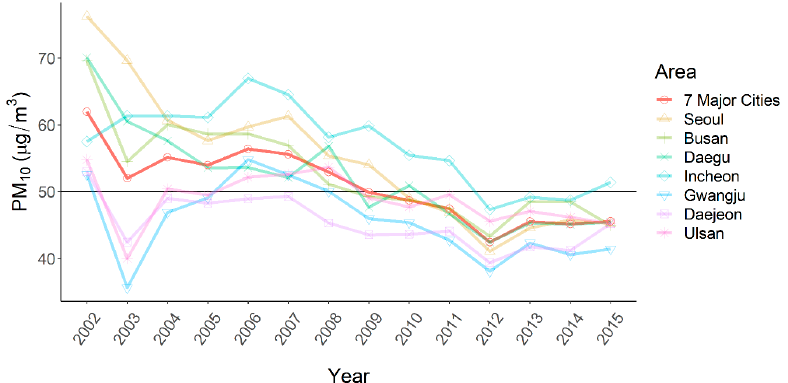
Figure 1. Annual averages of PM 10 concentration in the seven major cities of Korea (2002–2015). Figure 2 shows city-specific and pooled effect estimates for the short-term effects of PM 10 on stroke. The 10 µg/m 3 increase of PM 10 was associated with a 0.24% (95% CI: 0.04%, 0.44%) increase in hospital outpatients for ischemic stroke for the period 2002–2015. How- ever, we could not find statistically significant associations for hemorrhagic stroke (0.33%, 95% CI: − 0.06, 0.72) (Figure 2). The effect estimates tend to attenuate when we adjust the other air pollutants (Tables S1 and S2). Adjusting temperature extensively using the DLM did not change the estimated results (Tables S1 and S2). A partly negative association be- tween PM 10 and stroke outpatient was observed in the lagged exposure, presenting a pos- sibility for morbidity displacement (Figure S2).